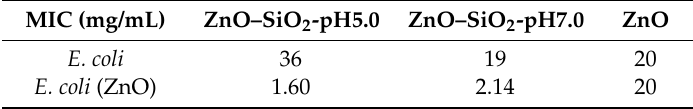
Table 3. MIC of ZnO–SiO 2 -pH5.0, ZnO–SiO 2 -pH7.0, and pure